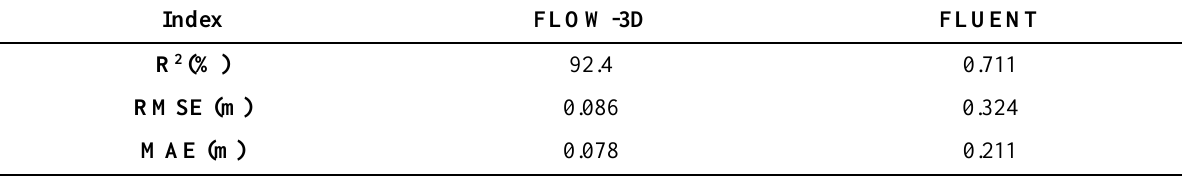
Fig. 6. Comparison of water level at 2.228 (m) using numerical models and experimental data. Comparison of the numerical models and experimental